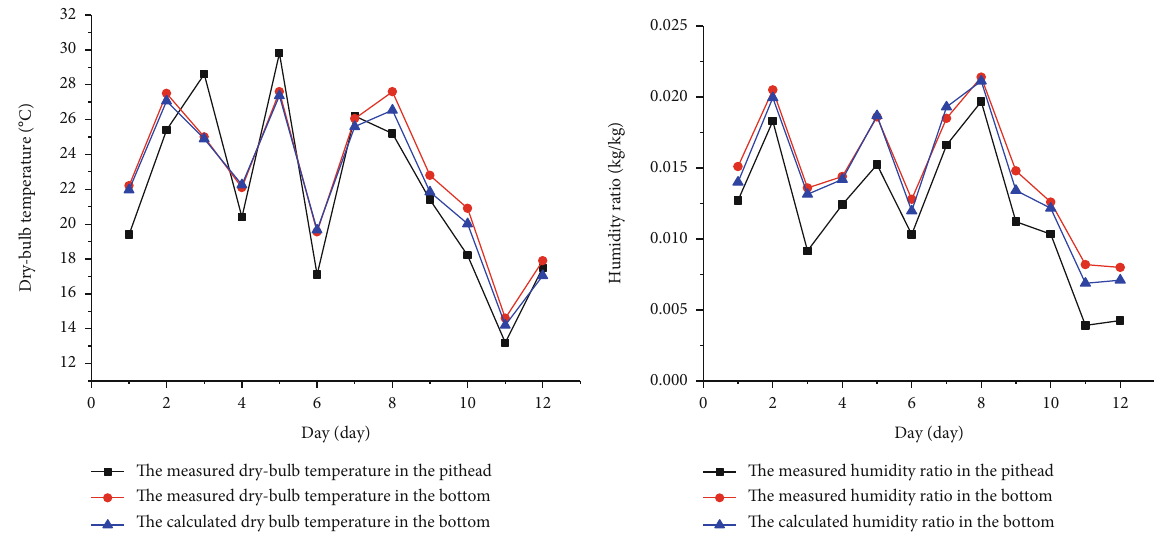
Figure 5: Comparison between the dry-bulb temperature and the humidity ratio of the calculated and measured in literature [24] at the shaft